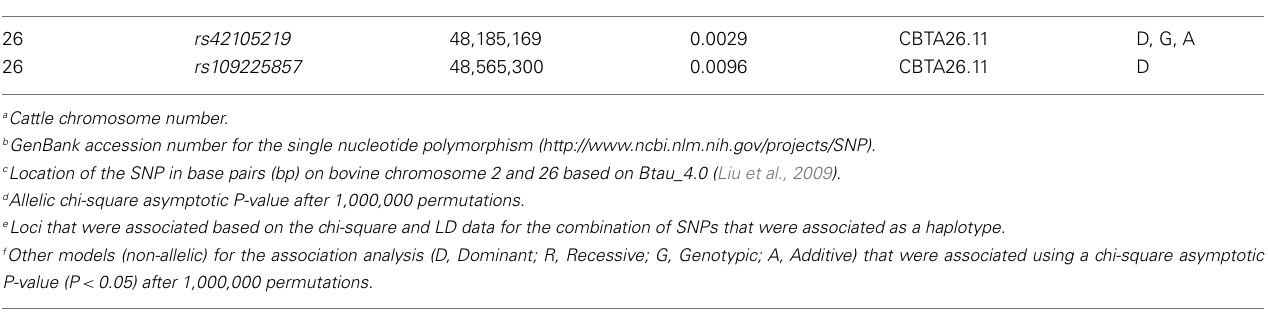
TableA3 | Single nucleotide polymorphisms that represent the loci linked with bovine respiratory disease on BTA2 and BTA26 with half-sib Brangus and Braford